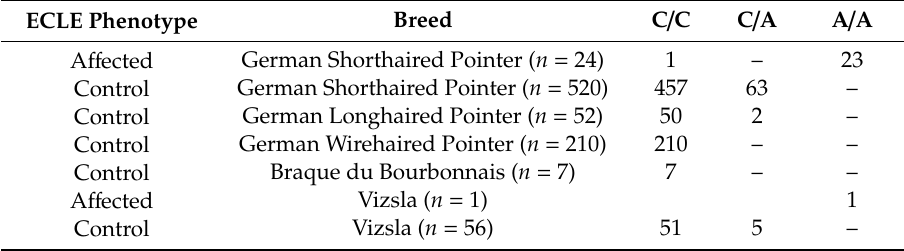
Table 2. Association of the genotypes at UNC93B1 :c.1438C > A with ECLE.